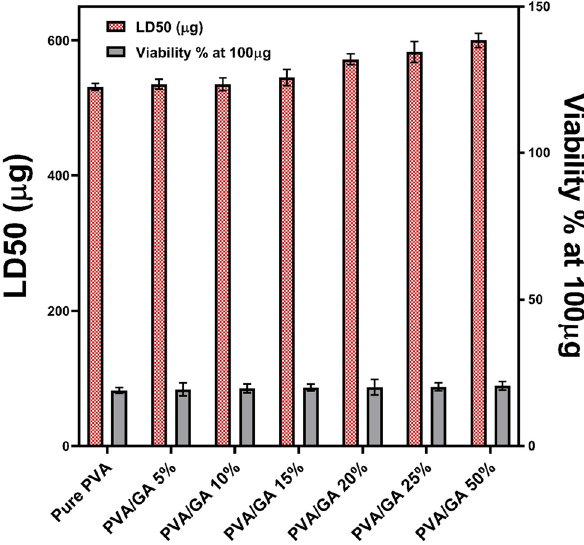
Figure 6: Percentage of wound area with time for control, pure PVA, and the PVA/GA x hydrogels. Concentrations ( x ) of GA are from 5% to 50%.